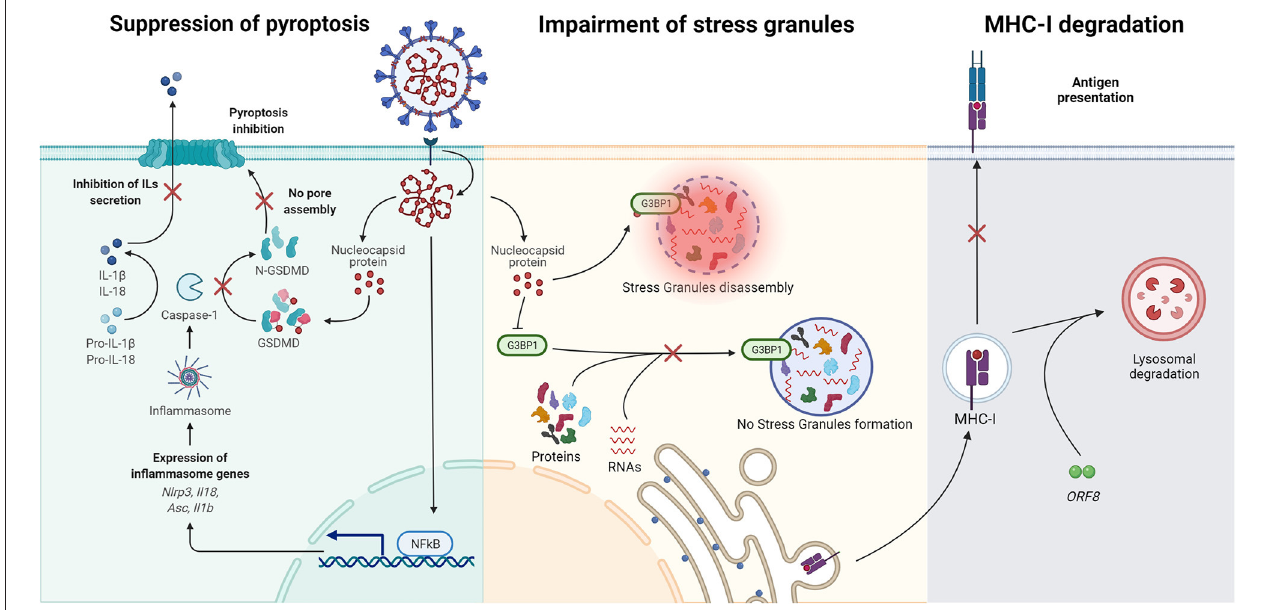
FIGURE 10 | Additional mechanisms for immune evasion. Left : impairment of pyroptosis. The interaction of the N protein with the linker peptide of GSDMD prevents cleavage of GSDMD by inflammasome-activated caspase-1, thus preventing N-GSDMD from assembling pores in the cell membrane and triggering pyroptosis. Center : impairment of Stress Granules. Binding of N protein to G3BP1 prevents G3BP1 interaction with other stress granules proteins, hampering formation of new stress granules and disassembling those already formed. Right : MHC-I degradation. SARS-CoV-2 ORF8 induces MHC-I lysosomal degradation, thus reducing antigen presentation on host